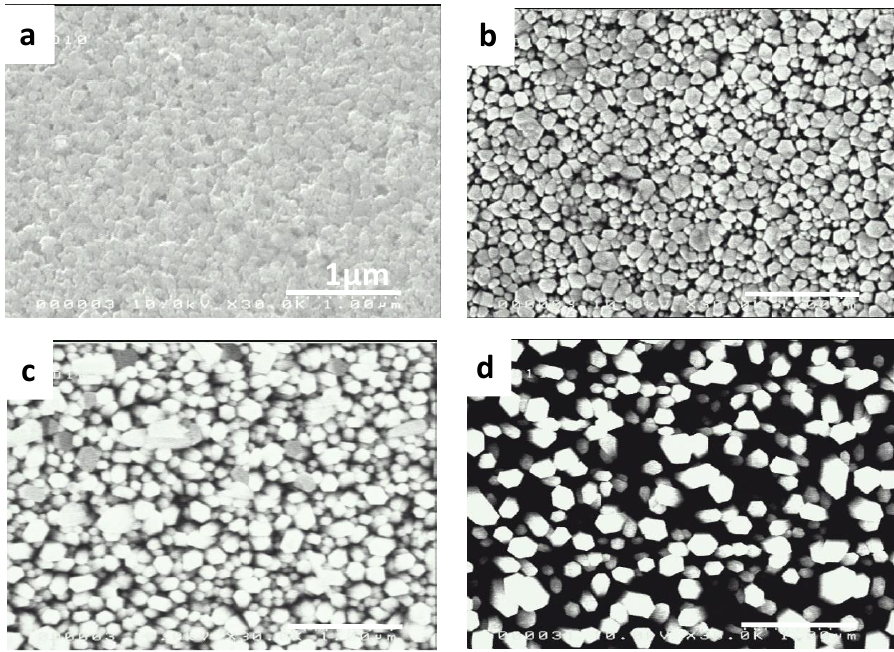
Figure 1. SEM images of ZnO NWs grown on AZO substrate during ( a ) 2 h, ( b ) 4 h, ( c ) 6 h, and ( d ) 15 h with fixed precursor concentration ratio of Zn(NO 3 ) 2 to HMTA and PEI ([Zn 2+ ]/[HMTA] = 1, [Zn 2+ ]/[PEI] = 300), respectively. All images are at the same scale (scale bar = 1 µm). Table 1. Morphology of ZnO NW grown on AZO substrate depending on the growing time. In all cases, the concentration of Zn(NO 3 ) 2 precursor solution was 50 mM, and the Zn(NO 3 ) 2 to HMTA and PEI ratios were defined as [Zn 2+ ]/[HMTA] = 1 and [Zn 2+ ]/[PEI] = 300.